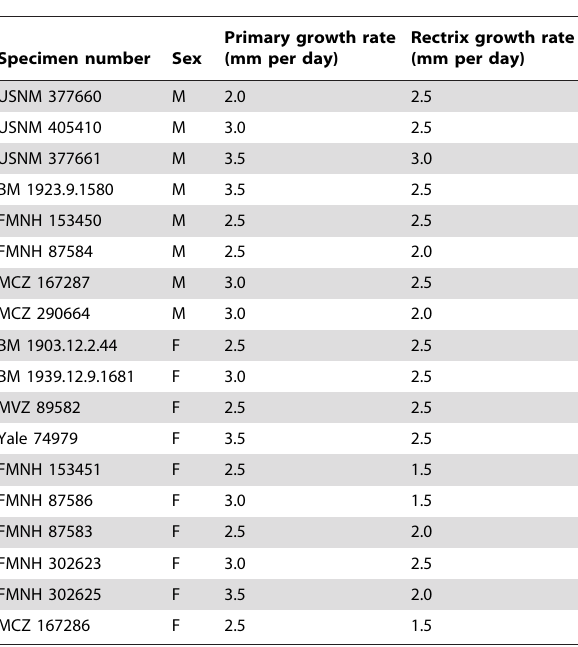
Table 5. Daily growth rate of primaries and rectrices for 18 Hemiprocne mystacea computed as the average distance between 6 pairs of growth bands for each